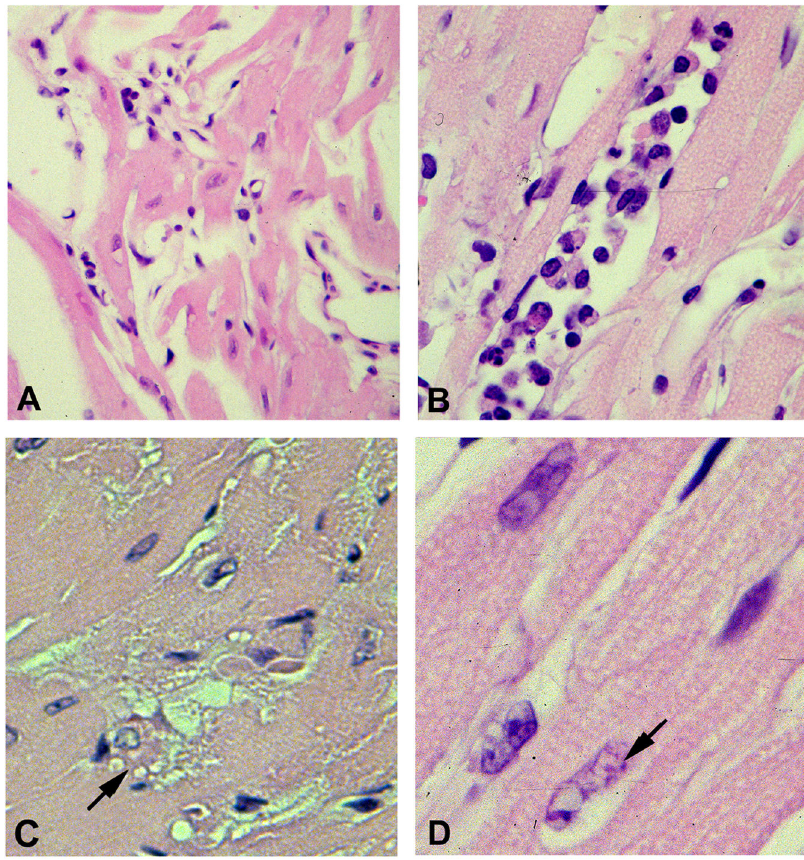
Figure 4. Cardiac NTT-MMP-2 expression induces progressive disruption of cardiomyocyte architecture, mononuclear cellular infiltration and apoptosis. Ventricular sections of 12 months old transgenic heart have grossly disordered cardiomyocyte architecture and diffuse mononuclear cell infiltration (panel A). There are frequent intense foci of mononuclear cell infiltration (panel B). Morphologic features of cardiomyocyte apoptosis, including cytoplasmic boiling (panel C, arrow) and nuclear chromatin peripheral condensation (panel D, arrow) are present. Final magnifications: A: X 300; B,C: X 600; D: X 900.